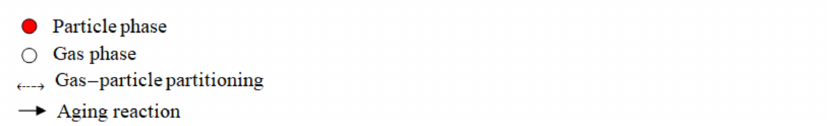
Figure 2. Schematic of the organic aerosol VBS-based modeling scheme in PMCAMx-SR.